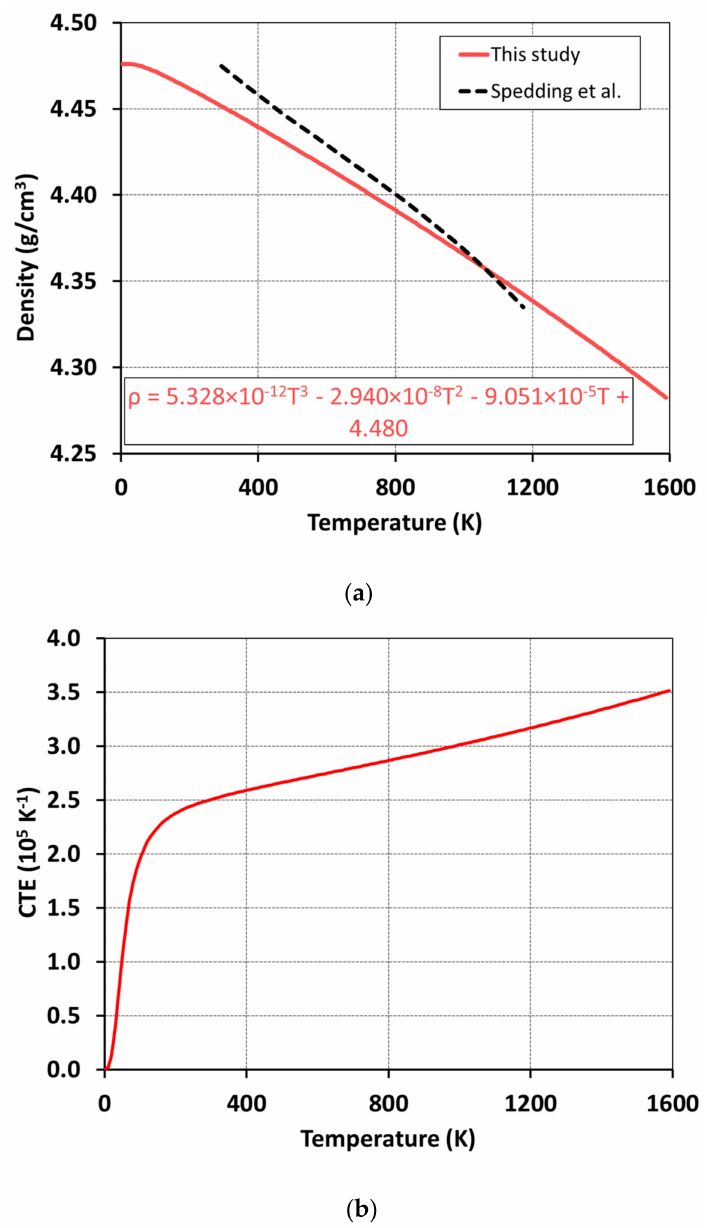
Figure 5. DFT-QHA-predicted ( a ) gravimetric density for α - Y . Modeling data compared with experimental reference [36], ( b ) coefficient of thermal expansion for α - Y